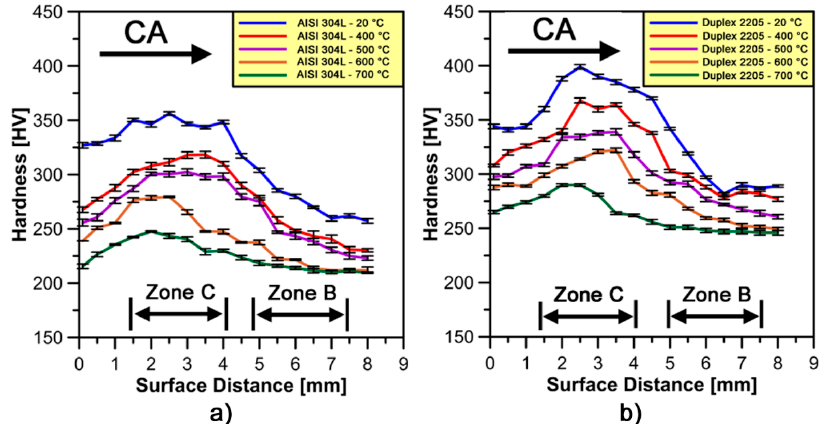
Figure 10. Average micro-hardness profiles as a function of distance along the compression axis (CA) for: ( a ) AISI 304L; and ( b ) Duplex 2205 stainless steel.